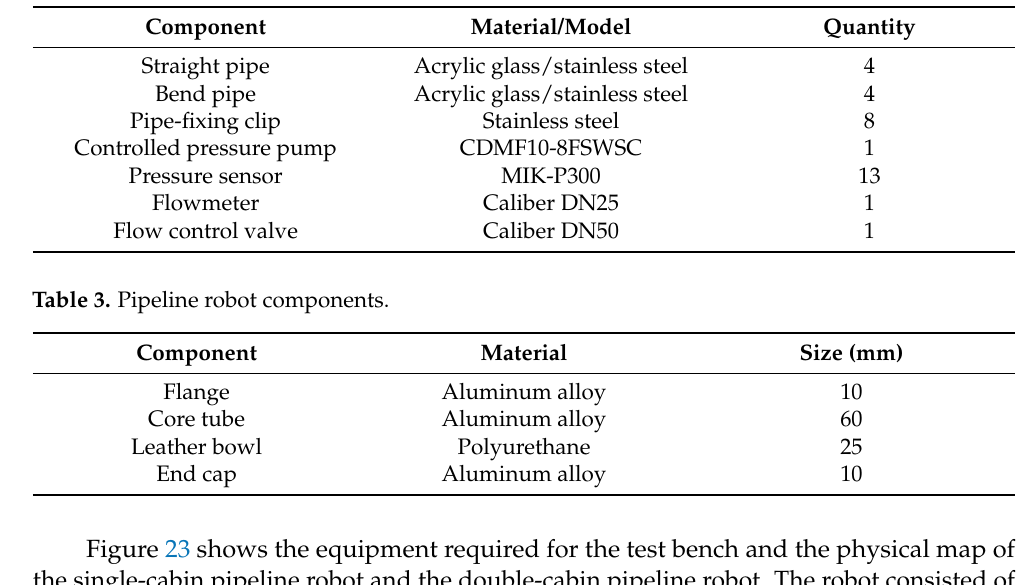
Figure24 . Pipeline robot with two − cup, four − cup and six − cup.